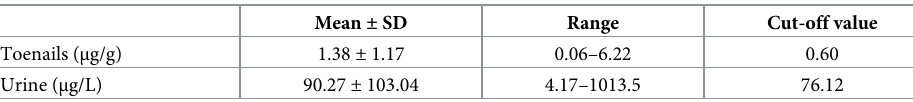
Table 3. As levels in biological samples from